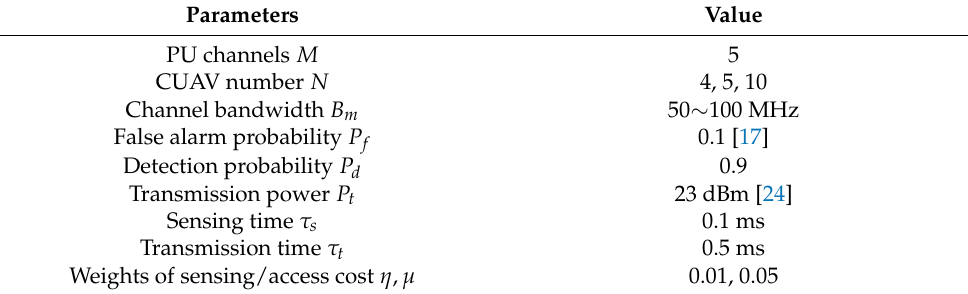
Table 1. Simulation parameters.